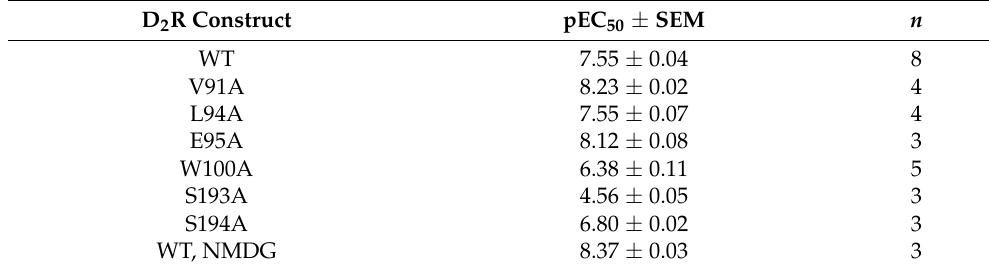
Table 1. DA potencies at the WT D 2 R (including the sodium-free condition; NMDG) and